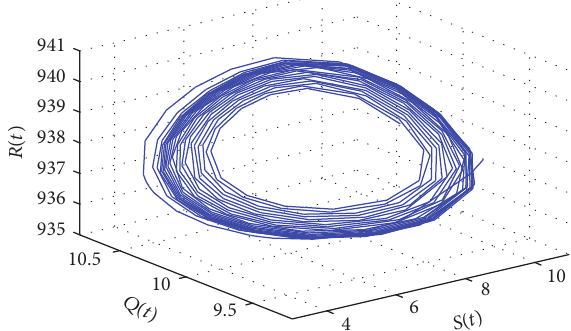
Figure 18: The phase plot of 𝑆 , 𝑄 , and 𝑅 when 𝜏 2 = 0.9755 > 0.8903 = 𝜏 󸀠 20 and 𝜏 2 = 1.05